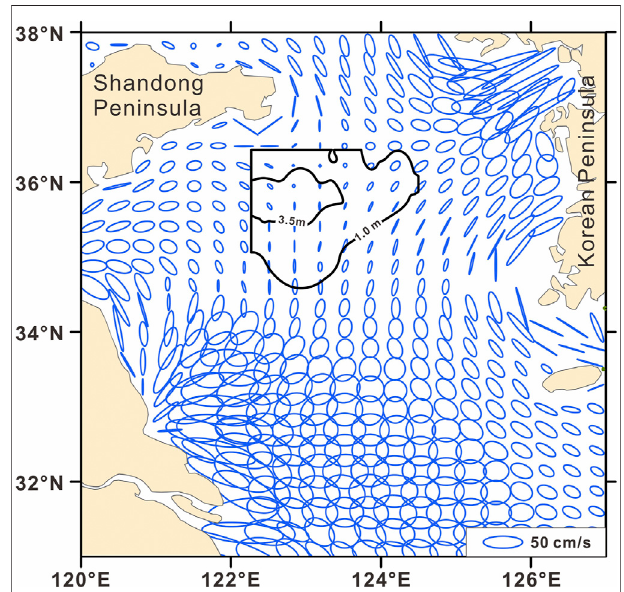
FIGURE 6 | Overlap of southern Yellow Sea tidal ecliptics (Liu et al., 2019) with Holocene mud thicknesses in the CYSM zone (bold black contours).